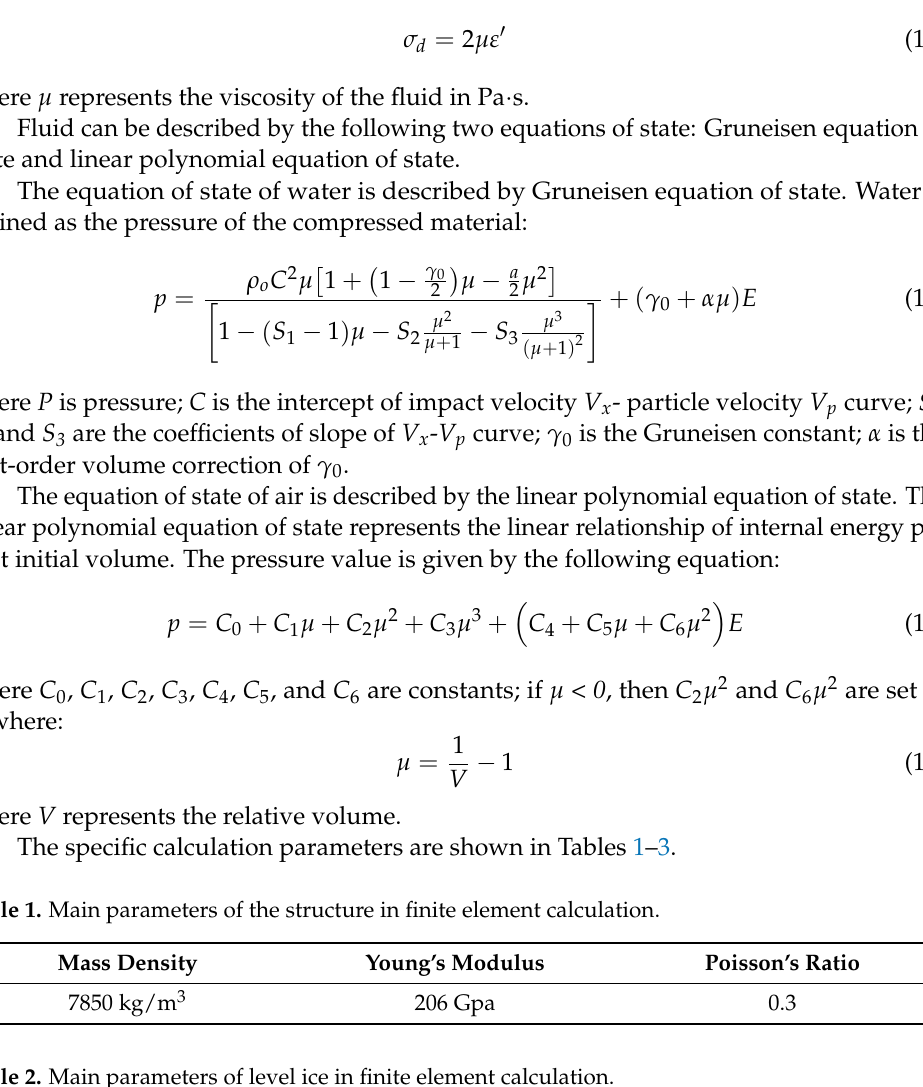
Table 2. Main parameters of level ice in finite element calculation.